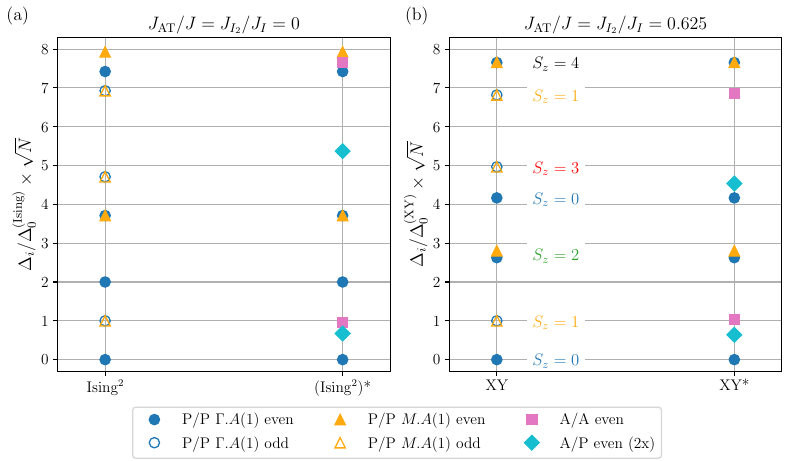
Figure 8: CTES for the (a) (Ising 2 )*, (b) XY* transitions for κ = 0. As a comparison, we show the CTES for the conventional Ising 2 and XY universality classes in the κ = 0 sector. The labels A / P etc. denote the boundary conditions along the two directions of the torus, where P (A) means periodic (antiperiodic). The boundary conditions correspond to the four different topological sectors of the (cid:90) TO phase on 2 the torus. Full (empty) symbols denote levels that are even (odd) under the global spin-inversion symmetry of the µ operators. In (b) we also indicate the emergent i S S sector of the spectral z